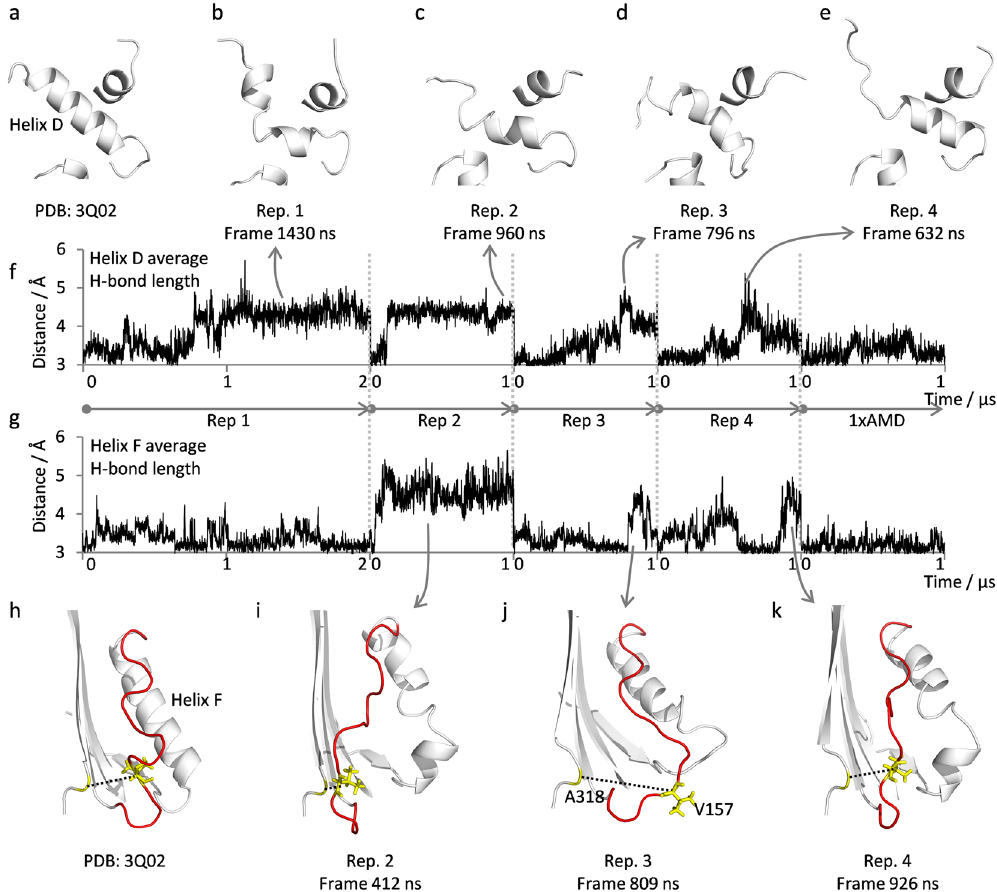
Figure 7. Helix D and F dynamics. Example structures of helix D and F configurations are shown in panels ( a–e and h–k ), respectively, from the indicated crystal structure and frames in the simulations on active PAI- 1. Structures are generally shown as white cartoon representation with the exception of the loop between helix F and β -strand 3 A which is displayed in red. Residues V157 and A318 are colored yellow and the distance between the C α atoms of these residues is illustrated by a black broken line and plotted as a function of simulation time in Figure S9. The average hydrogen bond lengths of helix D (all hydrogen bonds between 70 O:74 N and 79 O:83 N) and helix F (all hydrogen bonds between 128 O:131 N and 141 O:145 N) are plotted as a function of simulation time consecutively for all simulations on active PAI-1 in panel ( f and g ),